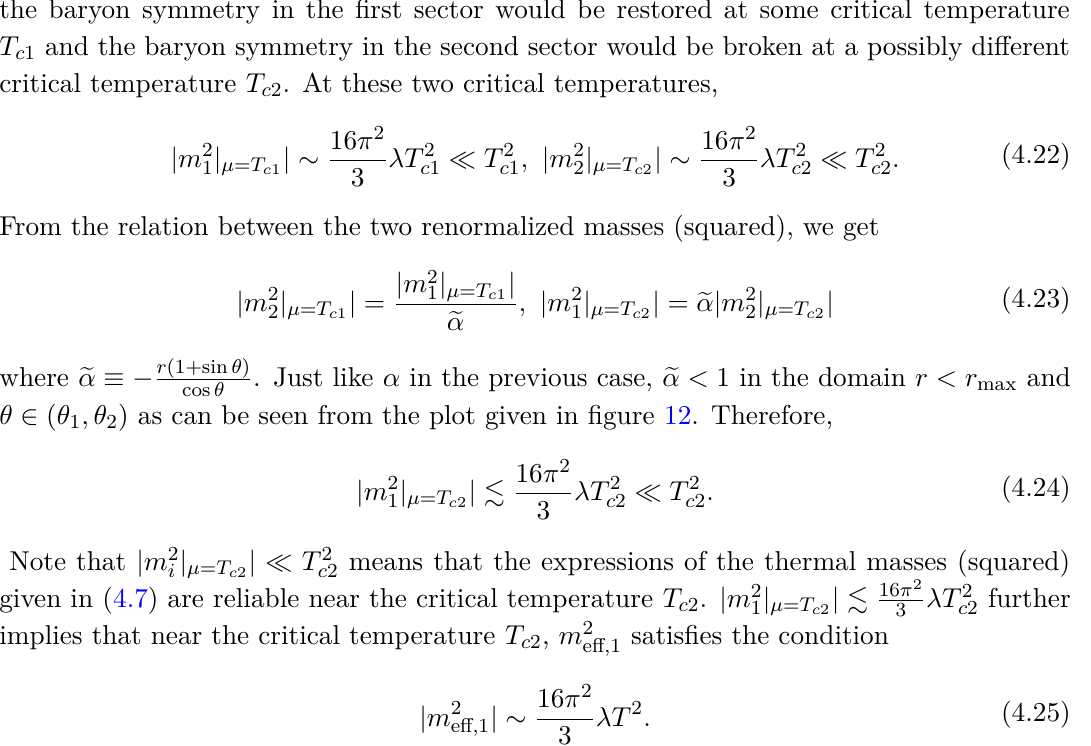
against r and θ in the domain r < r α = − r (1+sin θ ) e cos θ